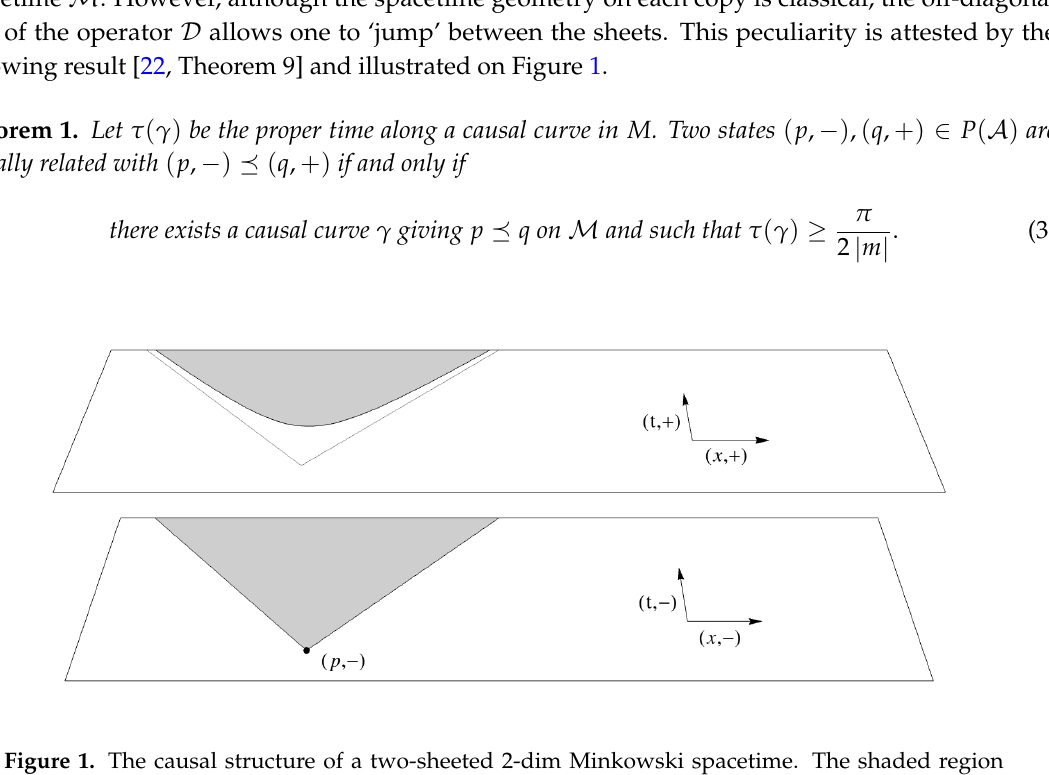
Figure 1. The causal structure of a two-sheeted 2-dim Minkowski spacetime. The shaded region illustrates the causal future of the event ( p , − )